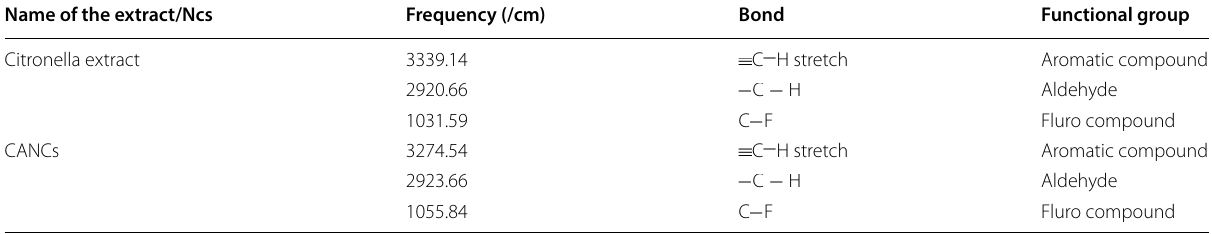
Table 2 FT-IR spectral analysis of the compounds present in crude extract and CANCs Name of the